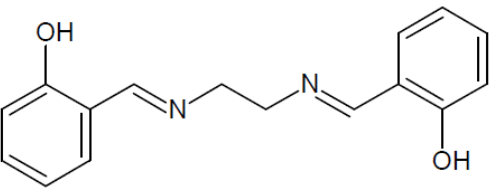
Figure 1. The structure of N,N’ -bis(salicylidene)ethylenediamine (L, salen).